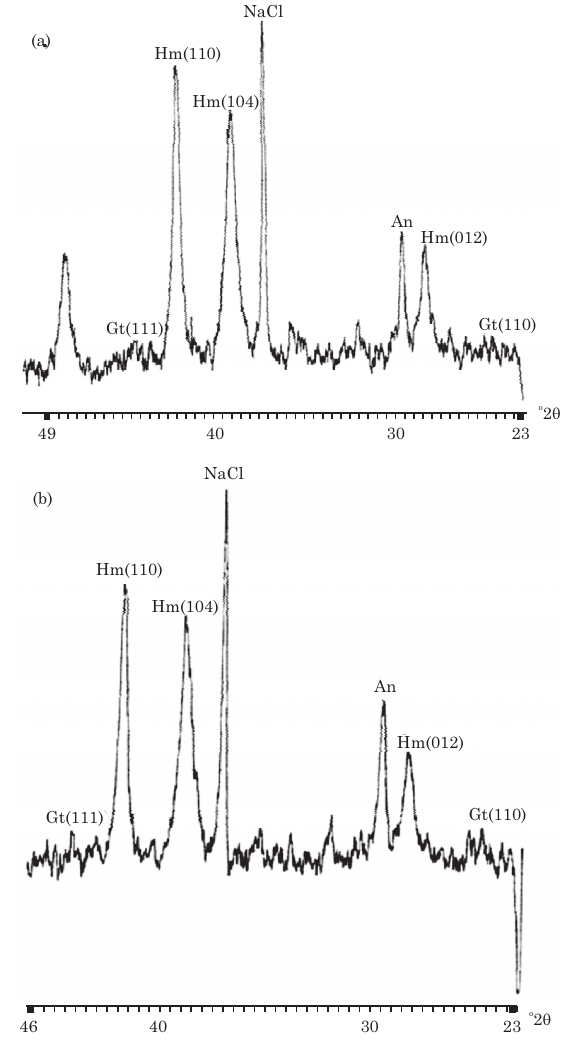
Figure 1. Diffractogram of iron oxide concentrated in the clay fraction of Latosols. (a) Mechanical harvesting; (b) Manual